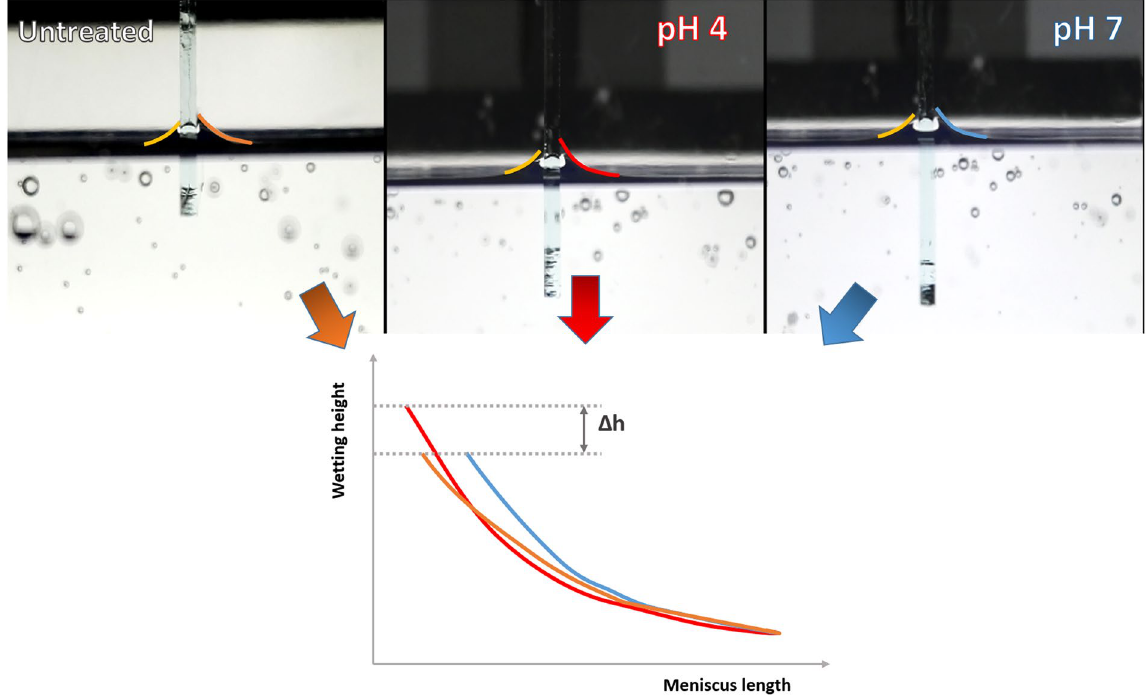
Figure 4. Wettability test performed following the Wilhelmy plate method. Coloured lines highlight the meniscus profiles resulting from immersion of the untreated (orange), pH 4 (red) and pH 7 (blue) mucin films in water. Left side of the glass slide remained